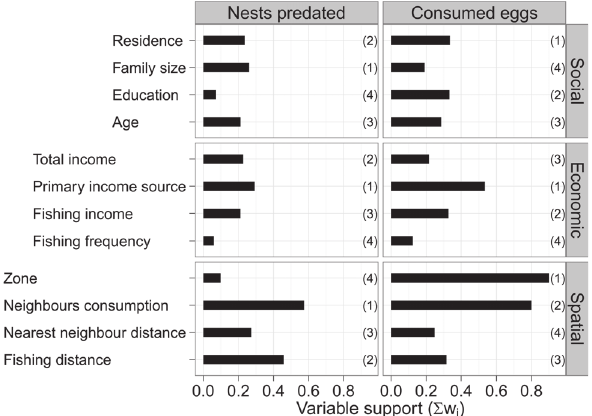
Figure 3. Ranking of support of explanatory variables grouped